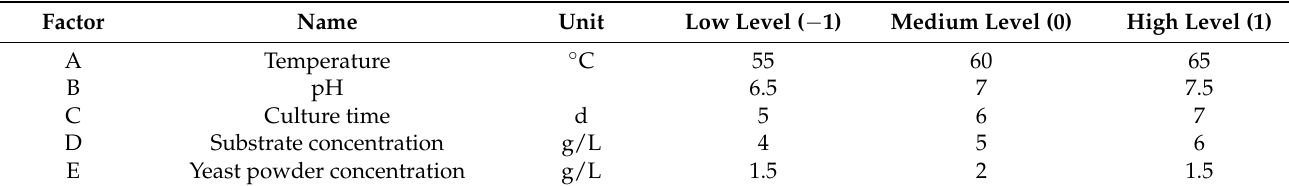
Table 1. Five factors and level